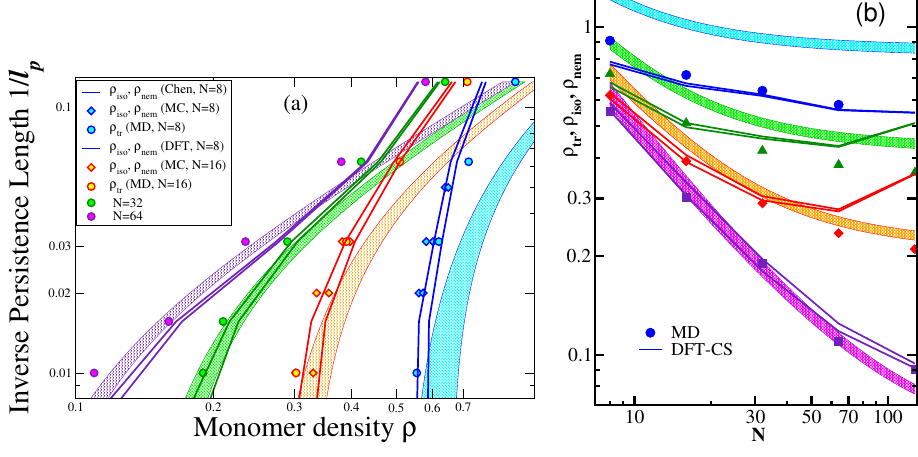
Figure 2. ( a ) Predictions for the I-N transition densities from [20] compared to MD and DFT results [43], in a log-log plot of inverse persistence length vs. density. Different symbols and different colors indicate the different chain lengths N = 8, 16, 32 and 64, respectively, as indicated in the key. The I-N coexistence regions predicted by Chen [20] are shown as shaded regions, while DFT-CS results are shown as curves, and symbols are Monte Carlo simulations (diamonds [49]) and MD simulations (circles [43]), respectively. Here, MD data show as a simple transition density ρ tr the inflection points of the S vs. ρ curves; ( b ) Same as (a), but choosing density and chain length N as variables. As in (a), shaded stripes are the two-phase coexistence regions predicted by Chen [20], full curves DFT-CS and symbols the MD data [43], for several choices of (cid:101) b : (cid:101) b = 8 (blue); (cid:101) b = 16 (green); (cid:101) b = 32 (red); (cid:101) b = 100 (purple, MD); (cid:101) b = 128 (purple, DFT-CS). Reproduced from [43] with permission from the Royal Society of